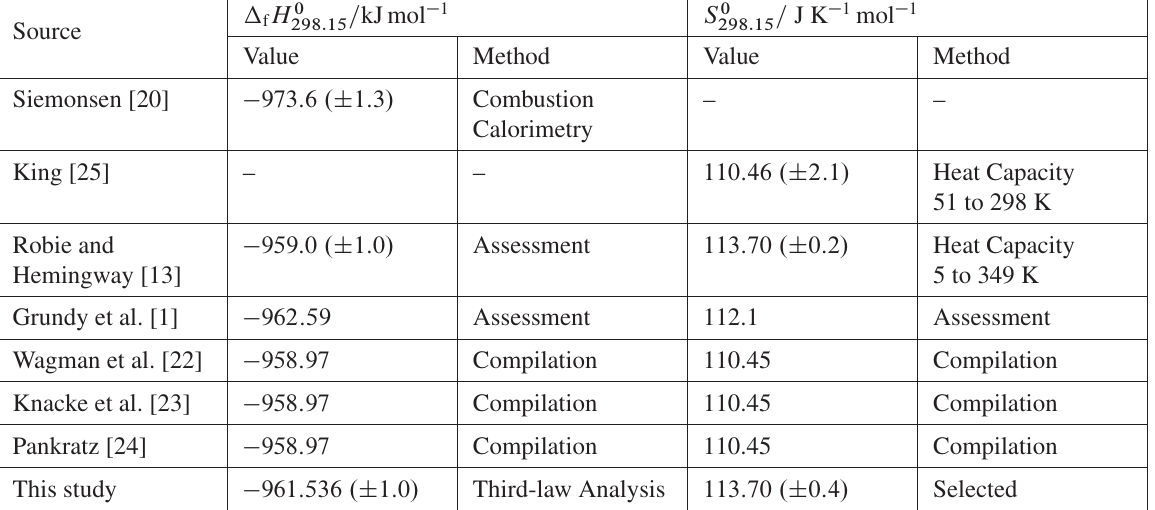
Table 5. Comparison of basic thermodynamic data for Mn 2 O 3 selected in this study with values reported in the literature.